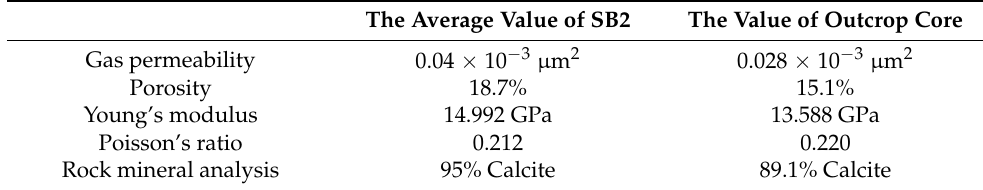
Table 1. Comparison of actual core and outcrop core parameters.